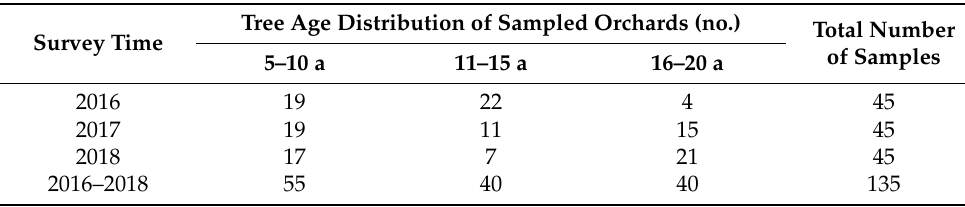
Table 1. Distribution and composition of sampled apple orchards in Beiquan Village, Luannan County, Hebei Province, China. Tree Age Distribution of Sampled Orchards (no.) Total Number Survey Time